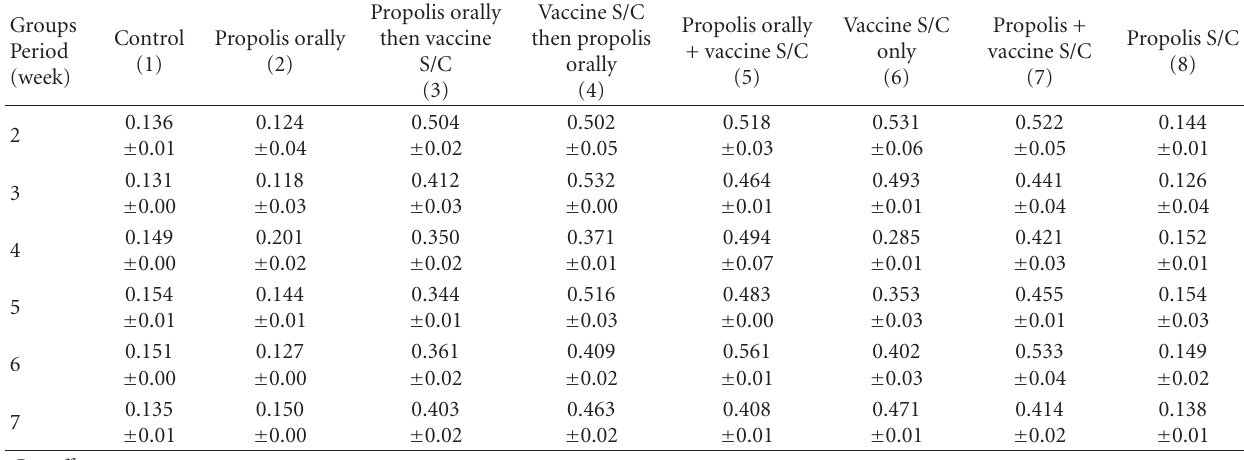
Figure 2: Serum glucose (a), total cholesterol (b), and triglycerides (c) in di ff erent experimental groups of rabbits received propolis and vaccine treatments for six weeks. Table 3: Enzyme-linked immunosorbant assay (ELISA) in di ff erent experimental groups of rabbits received propolis and vaccine treatments from the second till the seven week (mean ±